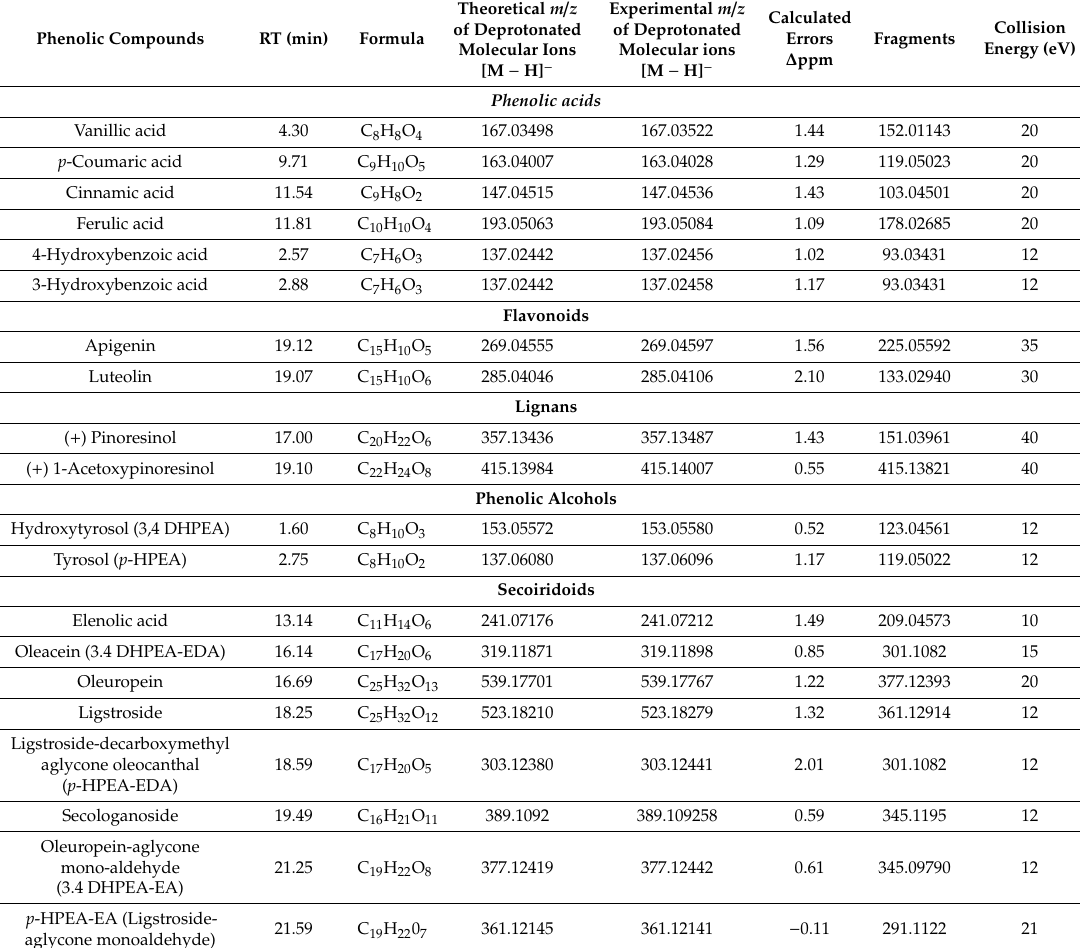
Table 1. Analyticalparametersofphenolicsidentification; allcompoundsweremonitoredinnegativemode.